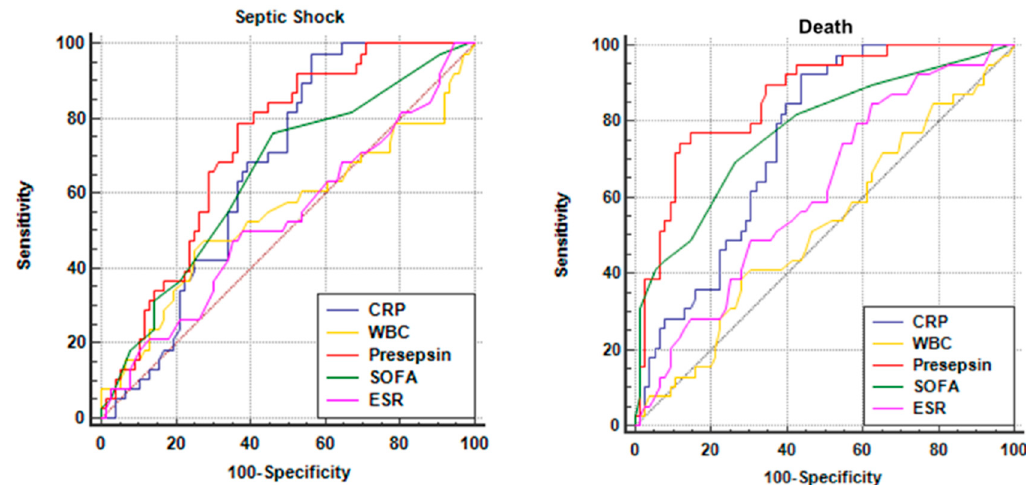
Figure 3. Comparison of receiver operating characteristics (ROC) curves for the study parameters (presepsin, CRP, erythrocyte sedimentation rate (ESR), white blood cells (WBC), and SOFA score) for predicting septic shock and death.